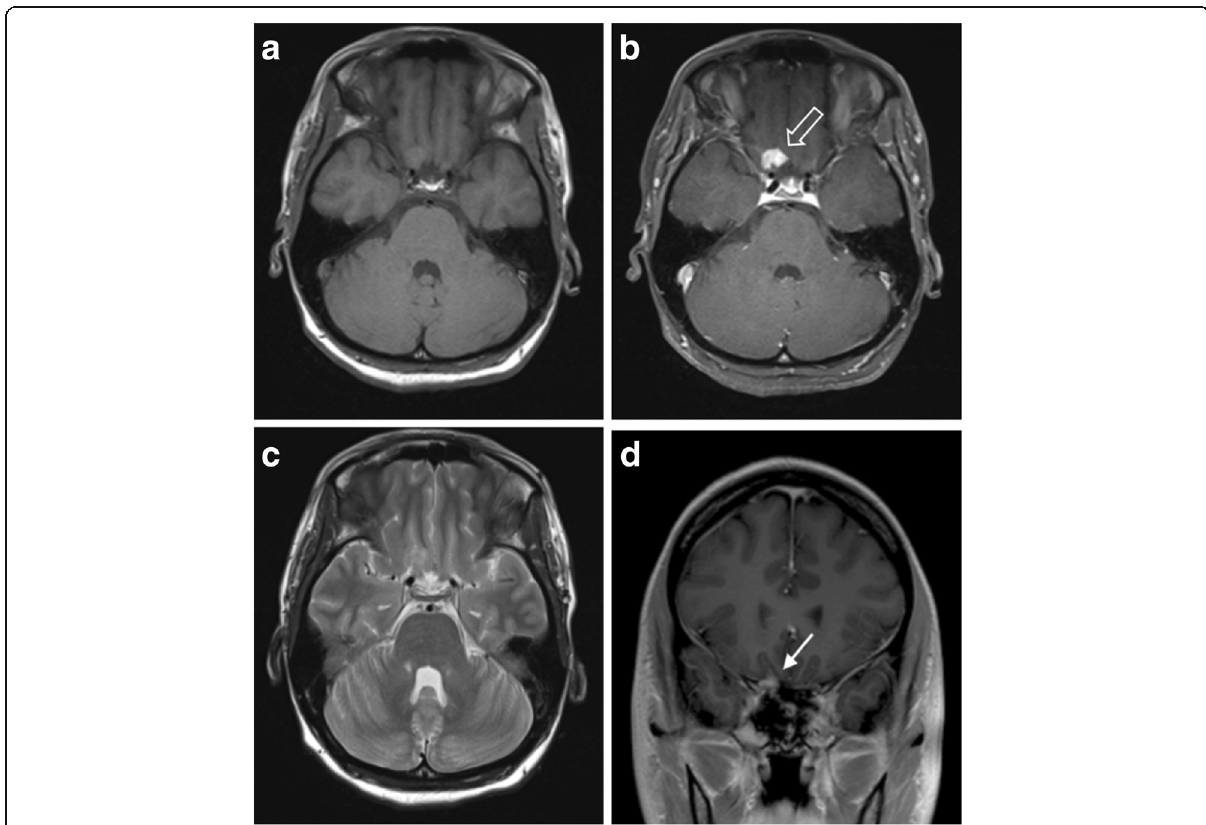
Fig. 11 Solitary tuberculoma. a , b Pre- and post-contrast axial T1-weighted MR images showing a strongly and homogenously enhancing lesion with a wide dural base at the right orbital apex (outlined arrow). No other intracerebral or meningeal lesions were seen. c T2-weighed axial MR image of the same lesion showing an isointense lesion with no associated vasogenic oedema. d Post-contrast coronal T1-weighted MR image demonstrating the lesion ’ s dural attachment (solid white